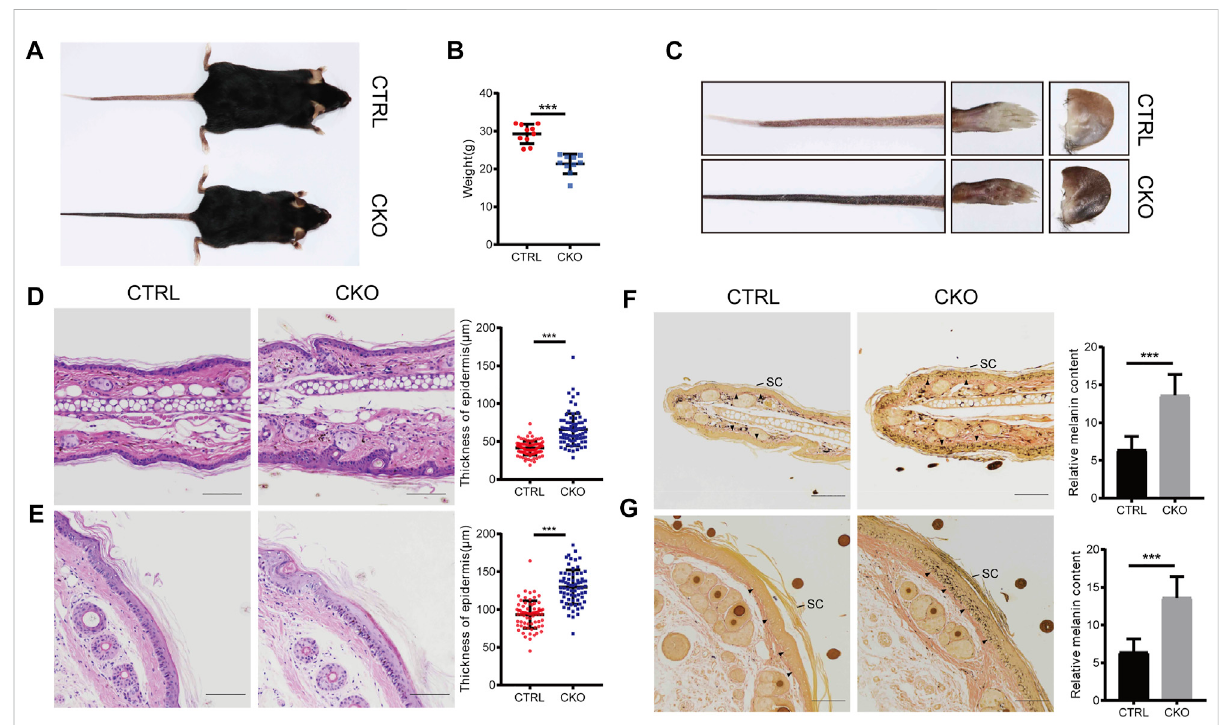
FIGURE 2 Loss of U fl 1 causes severe skin abnormalities in mice. (A) Images of mice with the indicated genotypes. (B) Body weight of mice in A. (C) Paws, tails and ears of the indicated mice as shown in A. (D,E) Tails and ears sections from CTRL and CKO mice were stained with hematoxylin and eosin (H&E)andepidermalthickness. (F,G) Masson-FontanastainingofthetailandearsectionsofmiceinC,andmelaninquanti fi cationoftheindicatedtail and ear samples. Arrowheads mark the dermal-epidermal border in panels. SC, stratum corneum. *** p < 0.001, unpaired Student ’ s test. Error bars represent ± s.d. The scale bar represents 100 μ